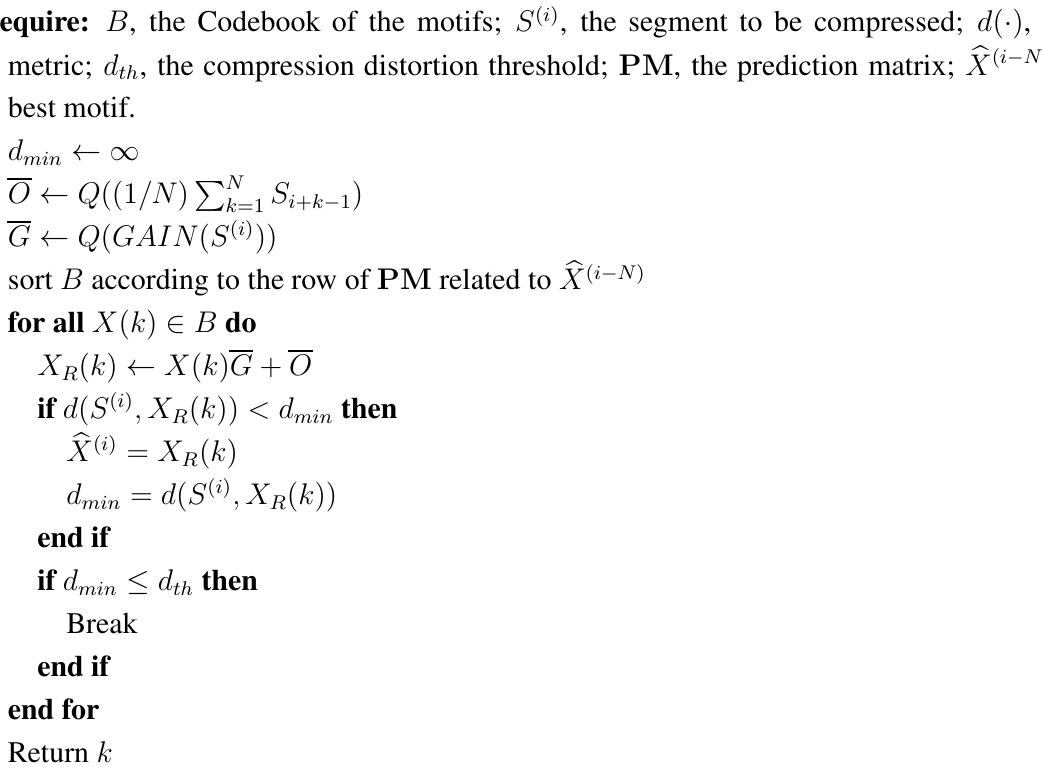
Algorithm 3 Motif selection algorithm with